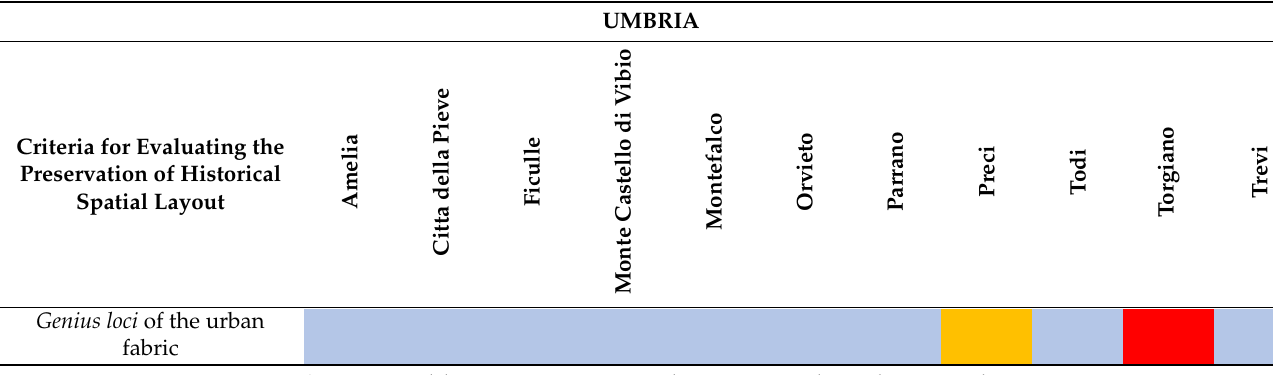
Table 17. Genius loci in Umbrian towns.